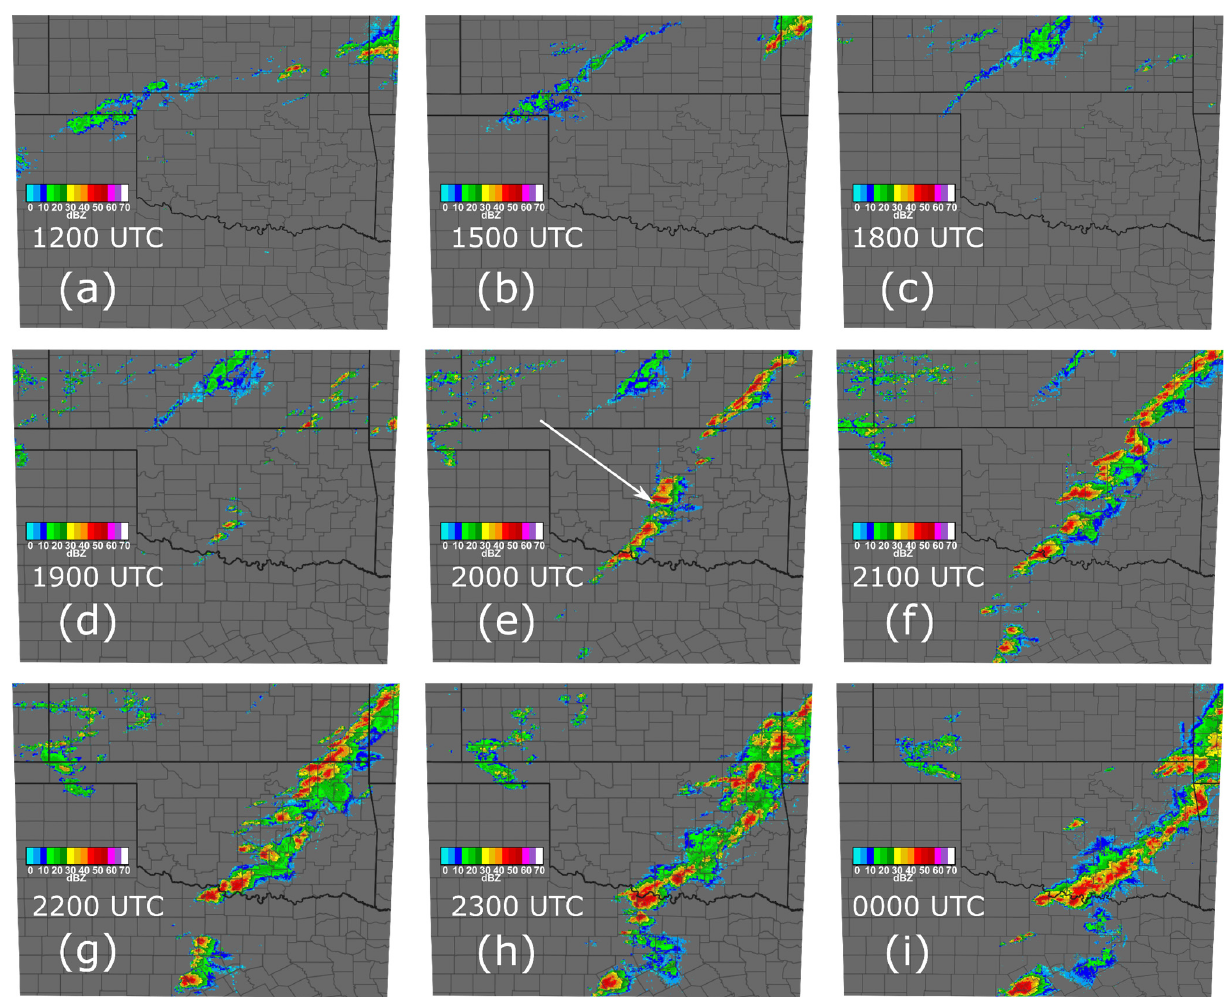
Figure 2. Observed composite base reflectivity for 20 May 2013 at ( a ) 1200 UTC, ( b ) 1500 UTC, ( c ) 1800 UTC, ( d ) 1900 UTC, ( e ) 2000 UTC, ( f ) 2100 UTC, ( g ) 2200 UTC, and ( h ) 2300 UTC, and for 21 May 2013 at ( i ) 0000 UTC. The white arrow in panel e shows the approximate location of the Moore tornado at that time. Imagery from the Iowa Environmental Mesonet (http://mesonet.agron.iastate.edu/GIS/apps/rview/warnings.phtml; accessed on 10 November 2021).